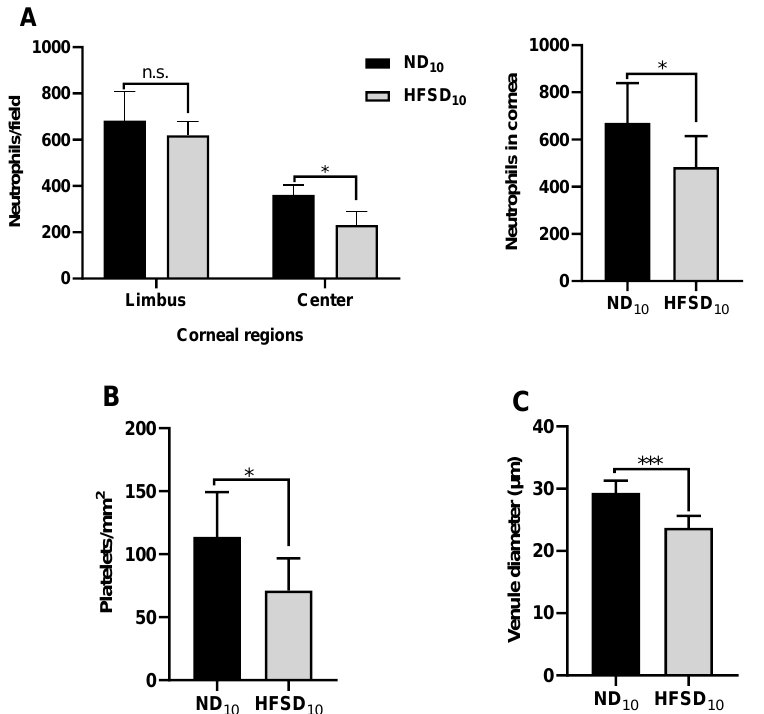
Figure 4. High-fat/sucrose diet feeding for 10 weeks dysregulates the inflammatory response of the cornea to abrasion when measured 30 h after wounding. ( A ) Left: The distribution of neutrophils over the limbal and central regions of the corneal stroma. Right: Sum of neutrophils in four fields of view from the periphery to the center of the cornea ( n ≥ 6), ( B ) Platelet counts at the limbus ( n ≥ 6). ( C ) Venule diameter at the corneal limbus of mice fed the normal or high-fat/sucrose diet. Data expressed as means ± SD. ND 10 —10-week normal diet; HFSD 10 —10-week high fat diet; n.s.—not significant; * p ≤ 0.05, *** p ≤ 0.001.